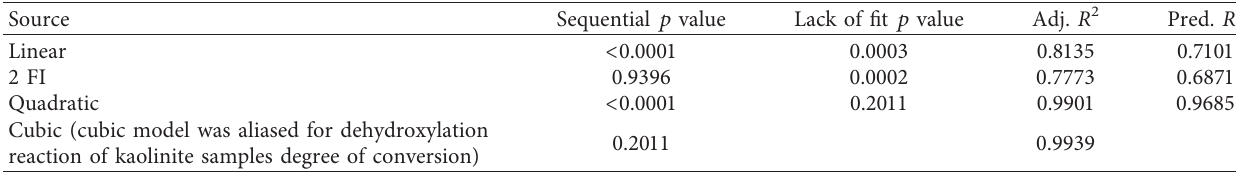
Table 4: Summary of lack of fit and statistical analysis in model selection for degree of conversion of kaolinite dehydroxylation reaction. Source